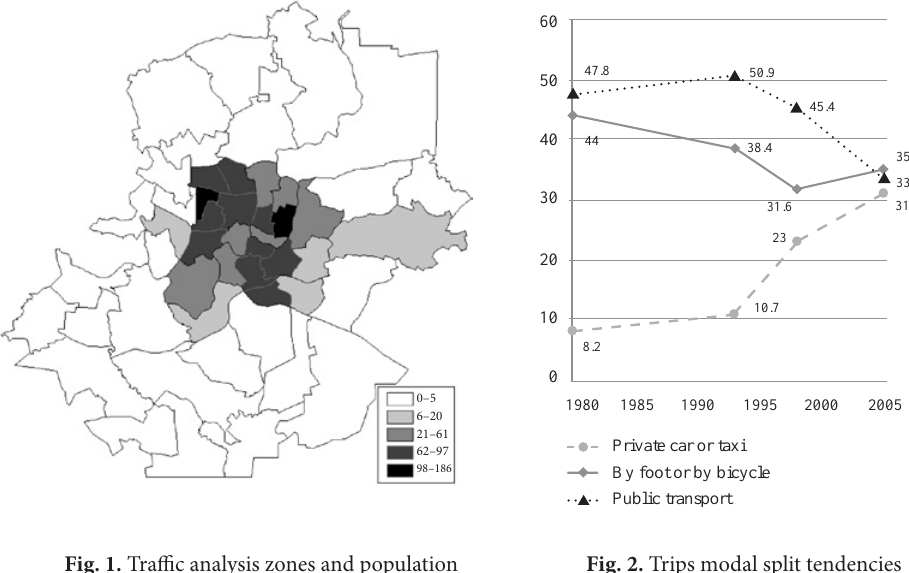
fig. 1. Traffic analysis zones and population density in Vilnius city